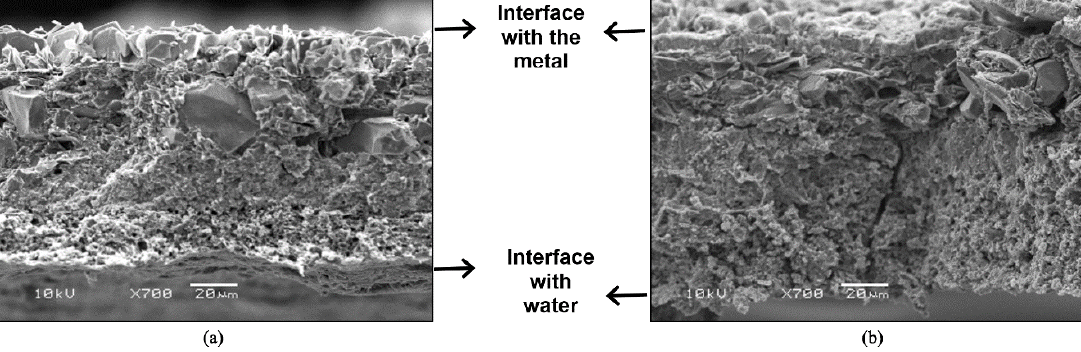
Figure 10. Micrographs of the coatings (a) T1-EMPy and (b) T3-EMPAniESPy after 53 weeks of